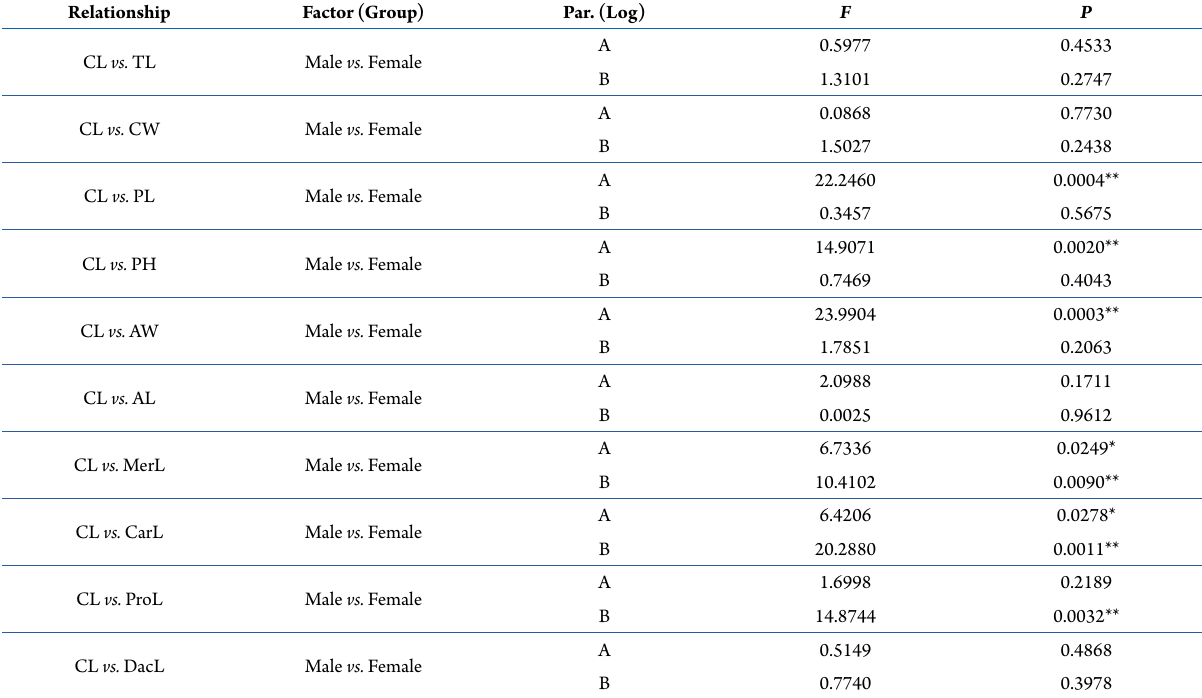
Table 3. Results of the Covariance Analysis (ANCOVA) of morphometric data for Atya scabra (Leach, 1816) at the Fluvial Island Domain in the Paraíba do Sul River basin. (CL) carapace length, (PL) length of the second abdominal pleuron, (PH) height of the second abdominal pleuron, (CW) carapace width, (TL) total length, (AW) abdomen width, (AL) abdomen length, (MerL) merus length, (CarL) carpus length, (ProL) propodus length, (DacL) dactylus length. Significant difference: * P <0.05; ** P